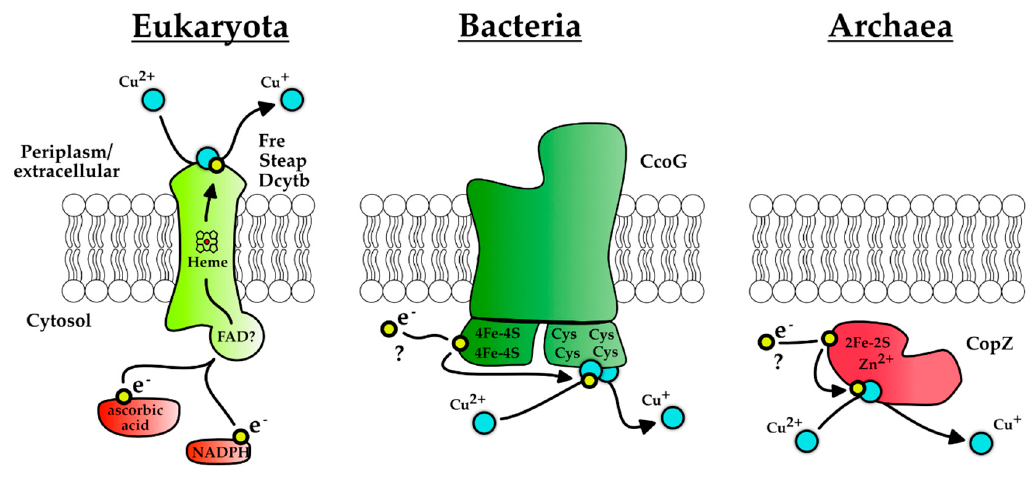
Figure 5. Schematic depiction of domain-specific copper-reducing enzymes. Eukaryotic cupric reductases are heme-containing, integral membrane proteins, such as Dcytb, or proteins of the Fre- and Steap-families. They contain an extracellular metal-binding site that is primarily used for Fe(III) reduction, but can also reduce Cu(II). Intracellular reductants, such as ascorbic acid or NADPH, serve as electron donors. The bacterial cupric reductase CcoG is specific for Cu(II) and reduces Cu(II) via two iron–sulfur clusters and an unknown physiological electron donor. The only described archaeal cupric reductase is a derivative of the cytosolic CopZ, using an iron–sulfur cluster and an unknown electron donor for reduction.